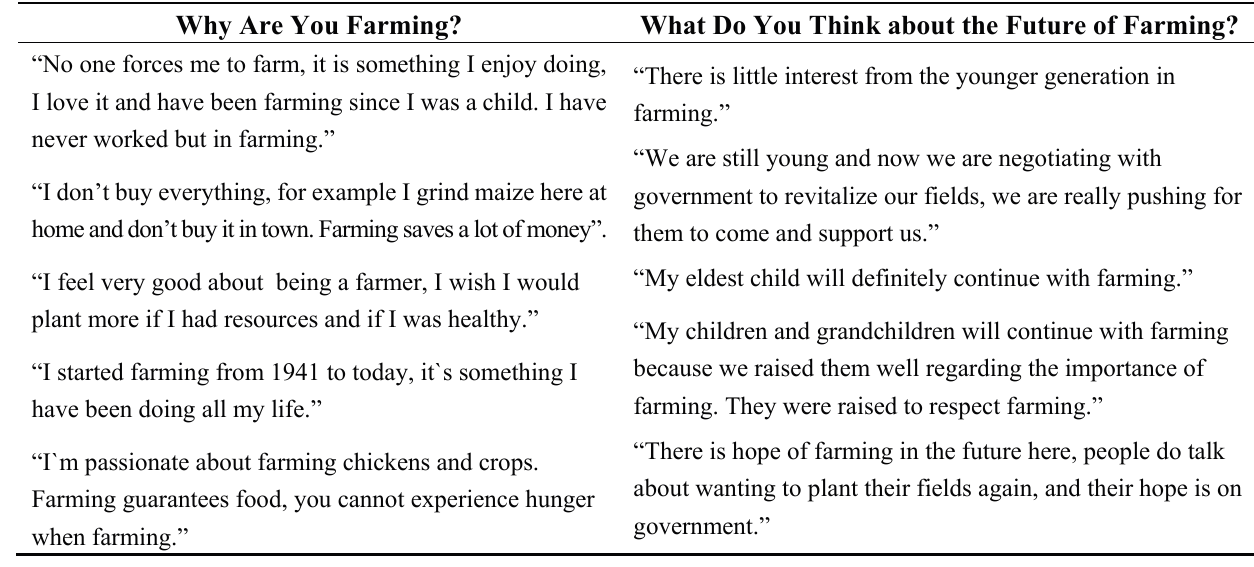
Table 3. Narratives from interviews with households still cultivating fields indicating that there is still life in arable farming in the rural Eastern Cape (n =